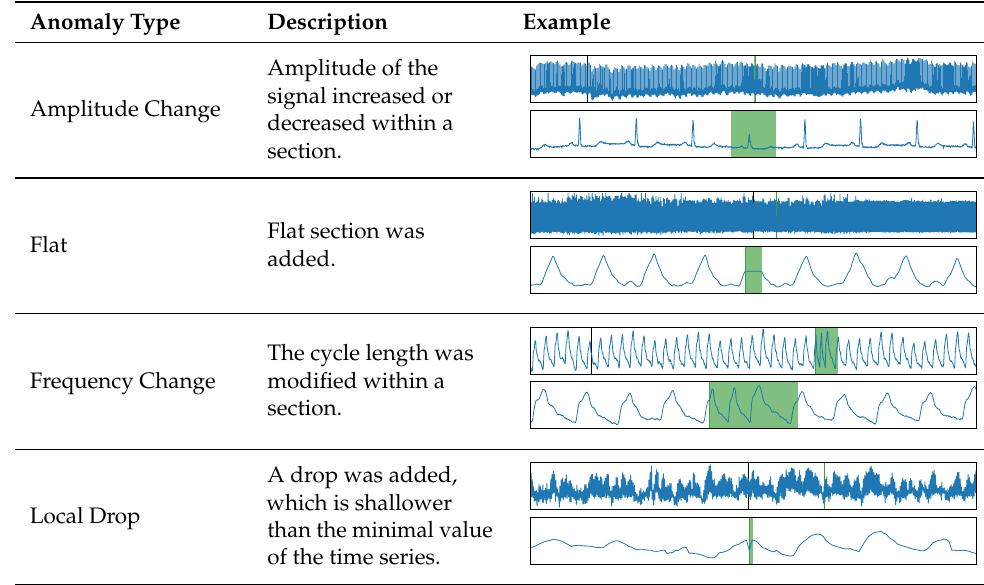
Table A1. Description of the annotated anomaly types in the UCR Anomaly Archive